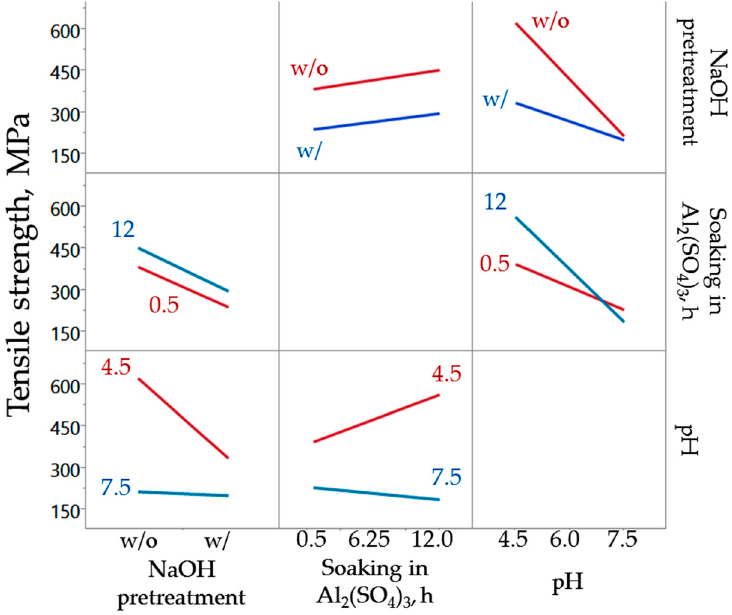
Figure 6. Interaction plot matrix of the factors for chemical treatment of the abaca fibers.